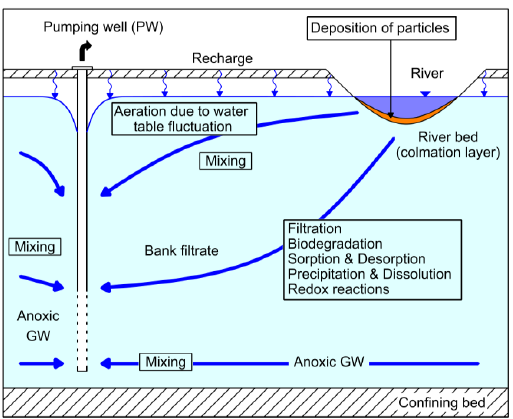
Figure 1. Schematic diagram of processes affecting iron and manganese concentration during riverbank filtration.